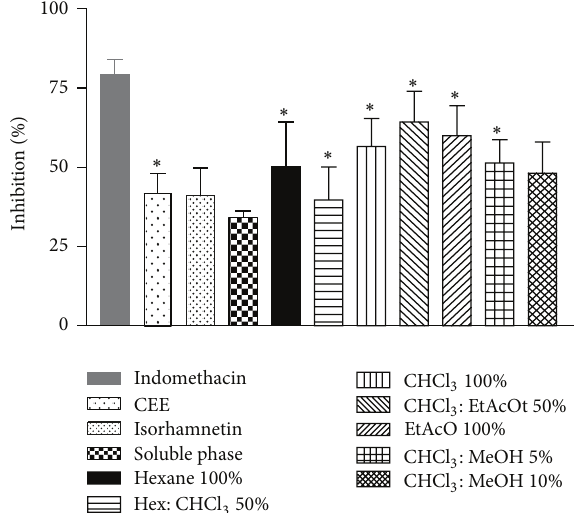
Figure 3: Effects of extract, fractions, and isorhamnetin (100mg/kg, p.o.) on the ear edema induced by capsaicin model. Each column represents the mean ± S.E.M. of 5 animals. The asterisks denote the significance levels in comparison with control groups, ∗ 𝑃 < 0.05 .